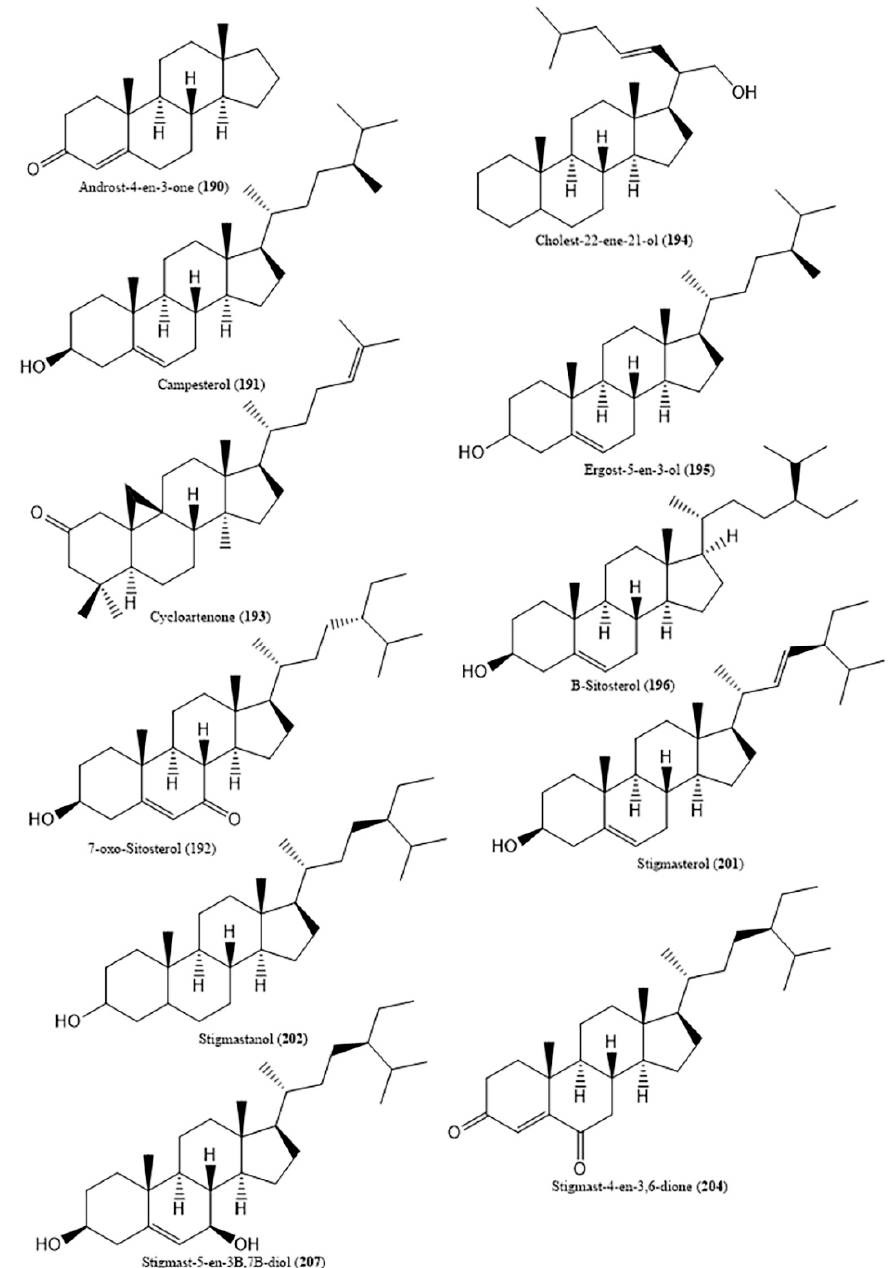
Figure 5. Some steroids and derivatives identified in halophytic grasses.